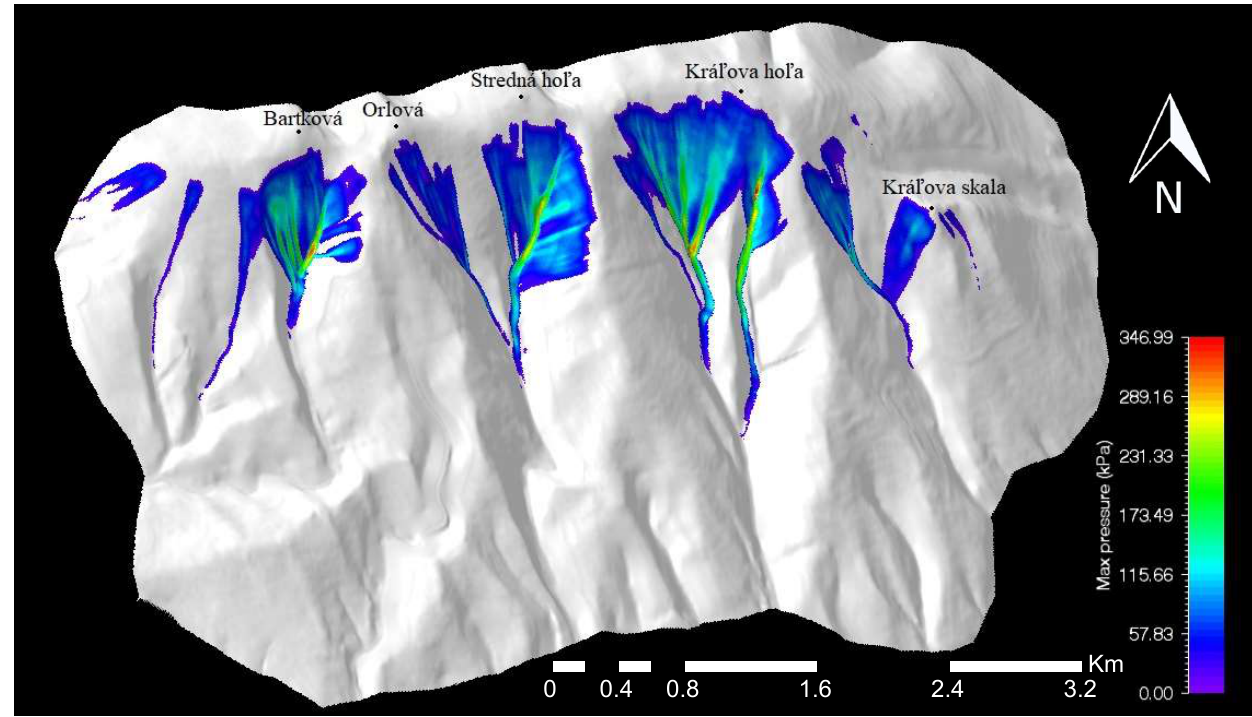
Figure 6. Maximum pressure exerted in avalanche fall (southern slope). The maximum snow flow height (Figure 7) on the northern slope of the examined area was 13.54 m. This value was measured in the final part of the Holičná valley at an altitude of approximately 1500 m a.s.l. at the foot of the steep rock walls surrounding the glacial circuit Holičná. Relatively high values of this factor were also measured at the northeastern foot of the Stredná hoľa (1876 m a.s.l.), as well as in the area of steep gutter casts at two locations: (1) the northwest slope of Kráľova hoľa (1946 m a.s.l.) emerging into the valley Veľký Brunov and (2) the northeast slope of Bartková (1790 m a.s.l.) emerging into a nameless valley under the aforementioned elevation. The lowest values of this factor were recorded on steep grassy slopes, similarly to the southern side of the studied area, under the peak areas of the low Tatra ridge at altitudes from 1420 m a.s.l. to 1800 m a.s.l.